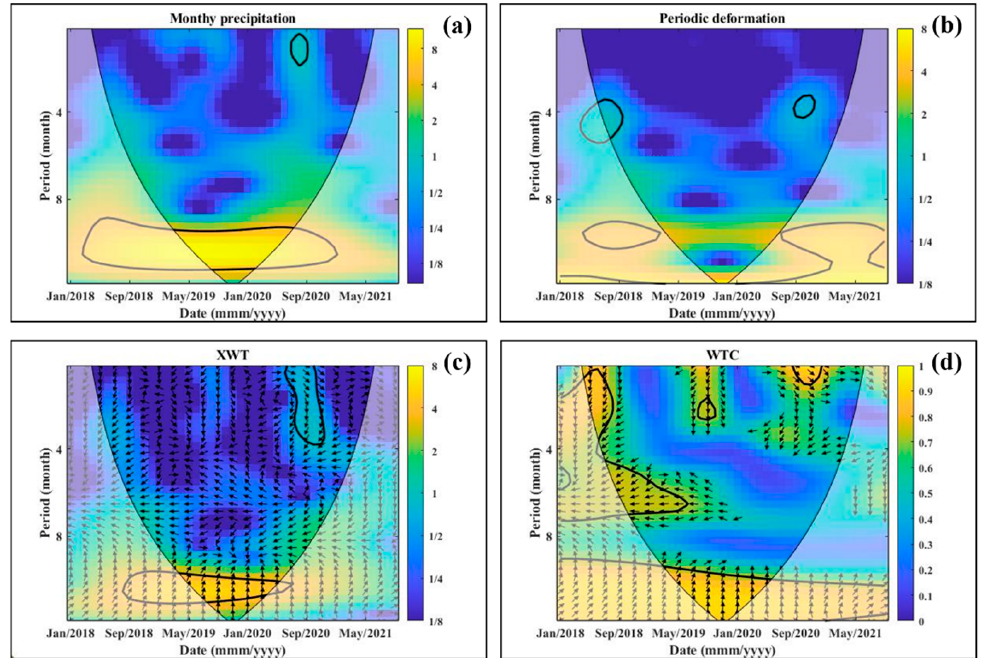
Figure 13. The relationship between deformation and monthly precipitation. ( a ) continuous wavelet power (CWT) of monthly precipitation; ( b ) continuous wavelet power (CWT) of periodic deformation; ( c ) cross wavelet transform (XWT) and ( d ) wavelet coherence (WTC) of periodic deformation and monthly precipitation for point P (see Figure 12a). Note that the thick contour designates the 95% significance level and the arrows represent phase relationships.